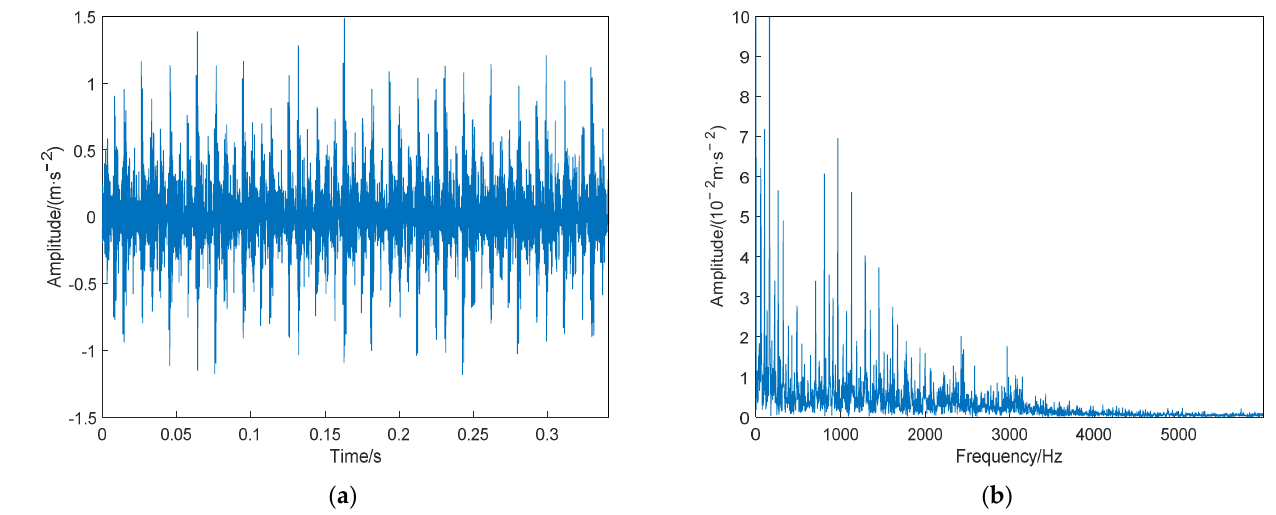
Figure 13. Time-domain waveform and envelope spectrum of the fault signal: ( a ) fault signal time-domain waveform; ( b ) Envelope spectrum of the fault signal.